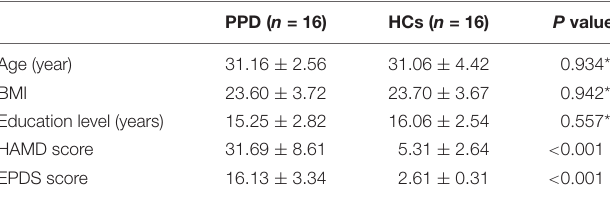
TABLE 1 | Demographic and depression rating scale of the